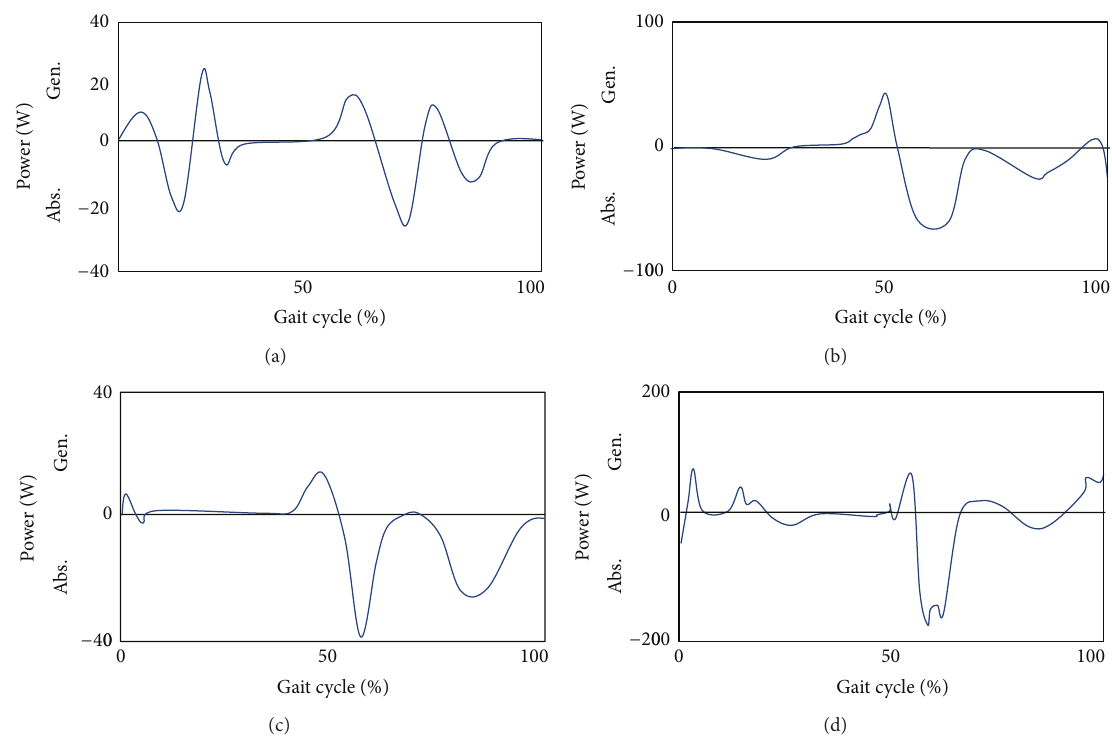
Figure 4: Knee power of different prosthetic knee systems, (a)–(d) adapted from four studies [6, 39, 40,